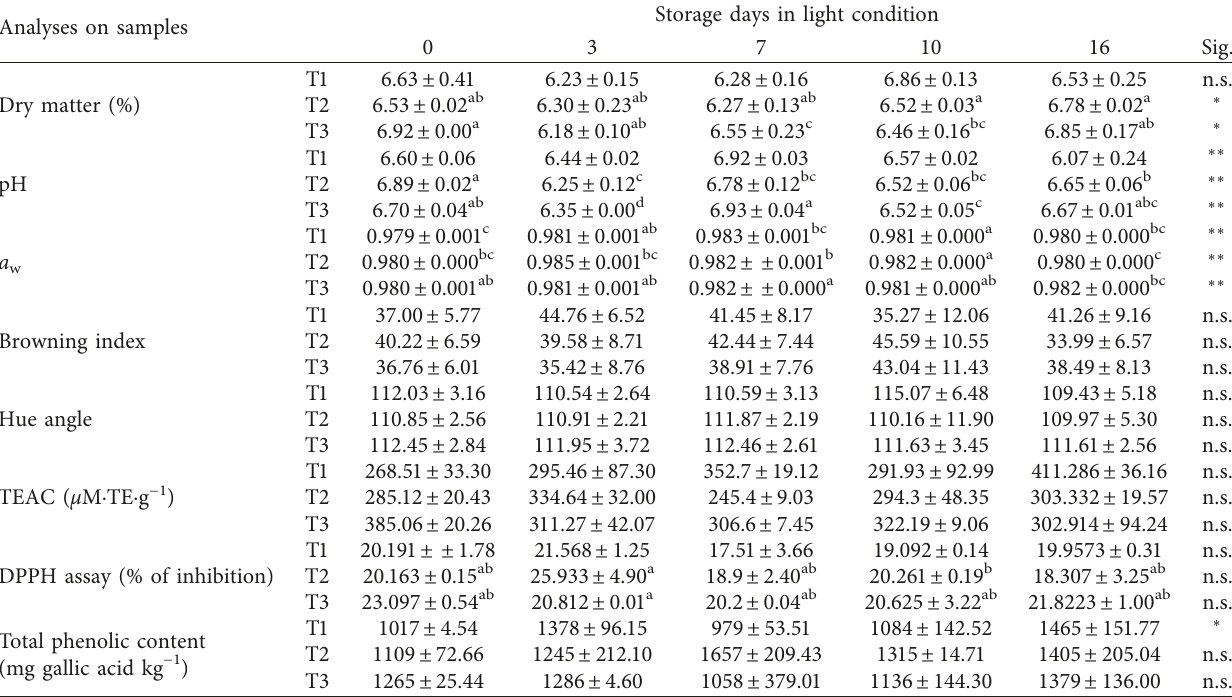
Storage days in light condition